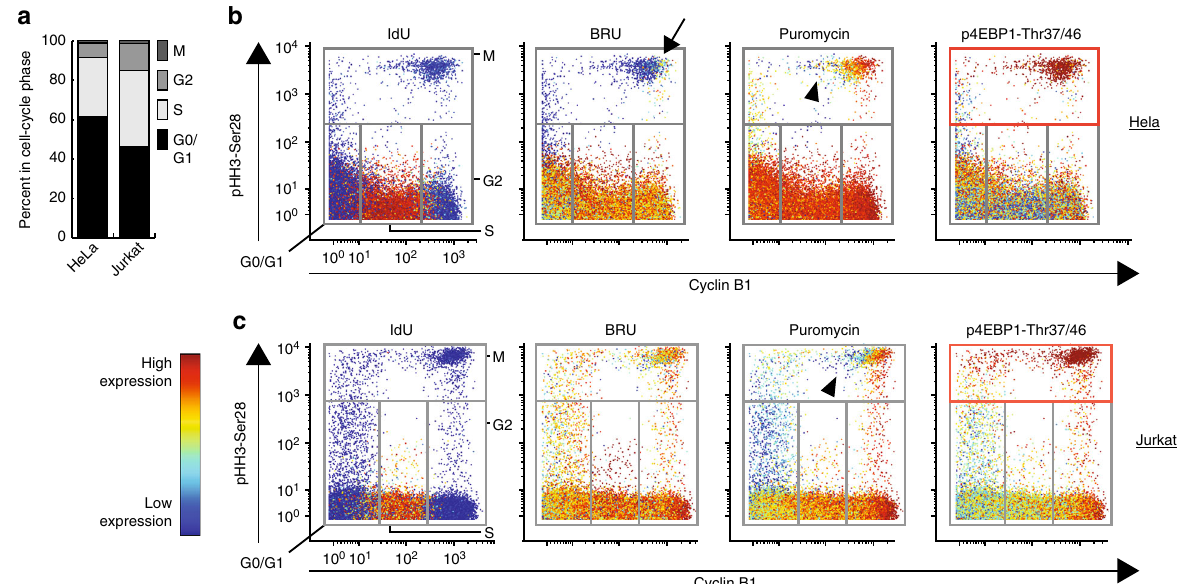
Fig. 2 de novo RNA and protein synthesis is suppressed in mitotic cells of asynchronously dividing human cell lines . a Cell-cycle phase breakdown of HeLa and Jurkat cell lines labeled with SOM 3 B. b Biaxial plot depicting cell-cycle progression of asynchronously dividing HeLa cells overlaid with SOM 3 B expression and phosphorylation status of 4EBP1-Thr37/46, arrow indicates early mitotic HeLa cells with low de novo RNA synthesis. (CyclinB1neg — G0/ G1, CyclinB1mid — S, CyclinB1high — G2, p-HH3-Ser28high — mitotic; expression color range — IdU: 0, 3460; BRU: 0, 697; Puromycin: 1.5, 600; p4EBP1: 0, 73). c Biaxial plot depicting cell-cycle progression of asynchronously dividing Jurkat cells overlaid with SOM 3 B expression and phosphorylation status of 4EBP1-Thr37/46. Arrow head in b and c mark downregulation of de novo protein synthesis in mitotic cells (CyclinB1neg — G0/G1, CyclinB1mid — S, CyclinB1high — G2, p-HH3 (S28) — mitotic; expression color range — IdU: 0, 676; BRU: 2, 1030; Puromycin: 8.5, 1060; p4EBP1: 5, 114). Experiments were performed multiple times, representative plots shown, 115,000 + cell events displayed for each cell